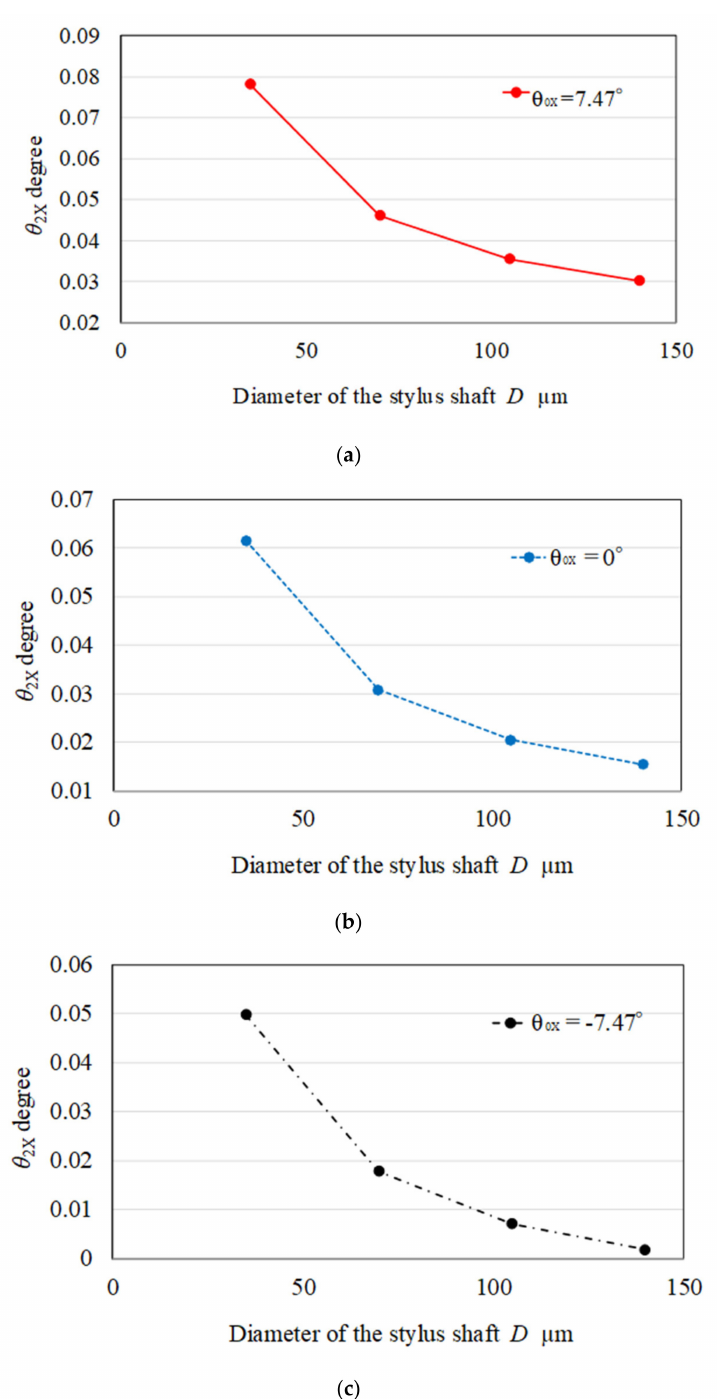
Figure 10. Simulated values of θ 2X (displacement of the stylus shaft along Y-axis = 0.03 µ m). ( a ) θ 0X = 7.47 ◦ ; ( b ) θ 0X = 0 ◦ ; ( c ) θ 0X = − 7.47 ◦